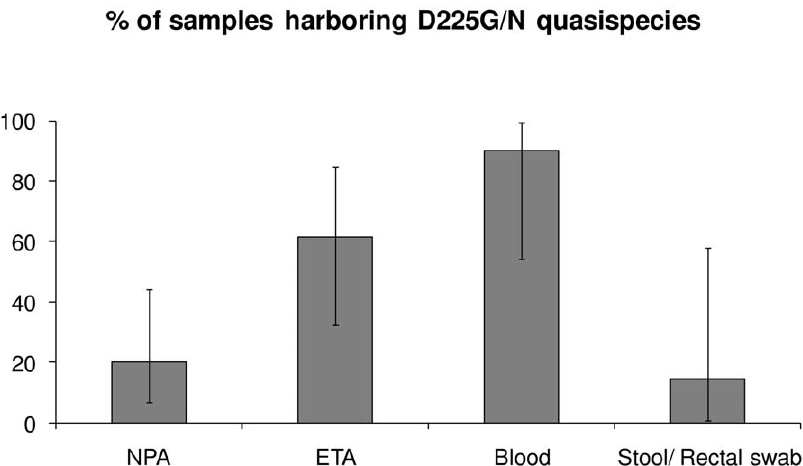
Figure 1. Proportion of samples with positive detection of D222G/N quasispecies in patients with positive viral RNA detection outside the respiratory